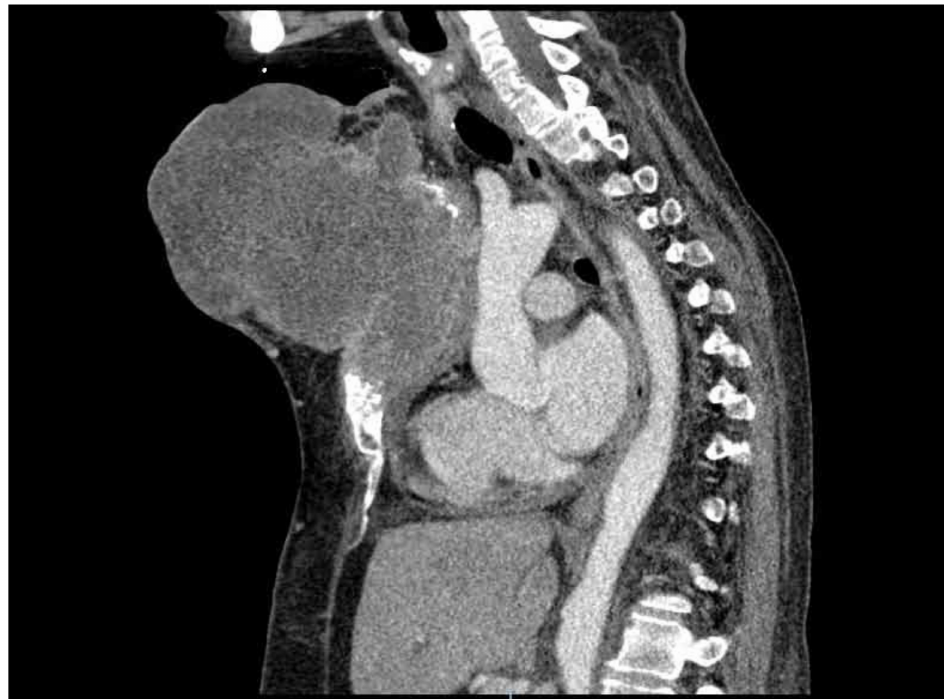
Figure 8. Preoperative CT scan (sagittal view).